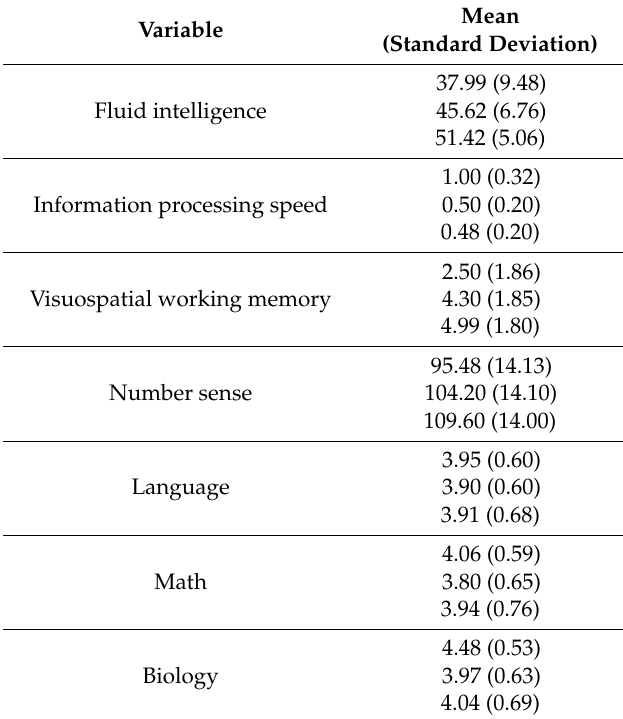
Table 1. Descriptive statistics of cognitive abilities and academic success at primary, secondary, and high levels of school